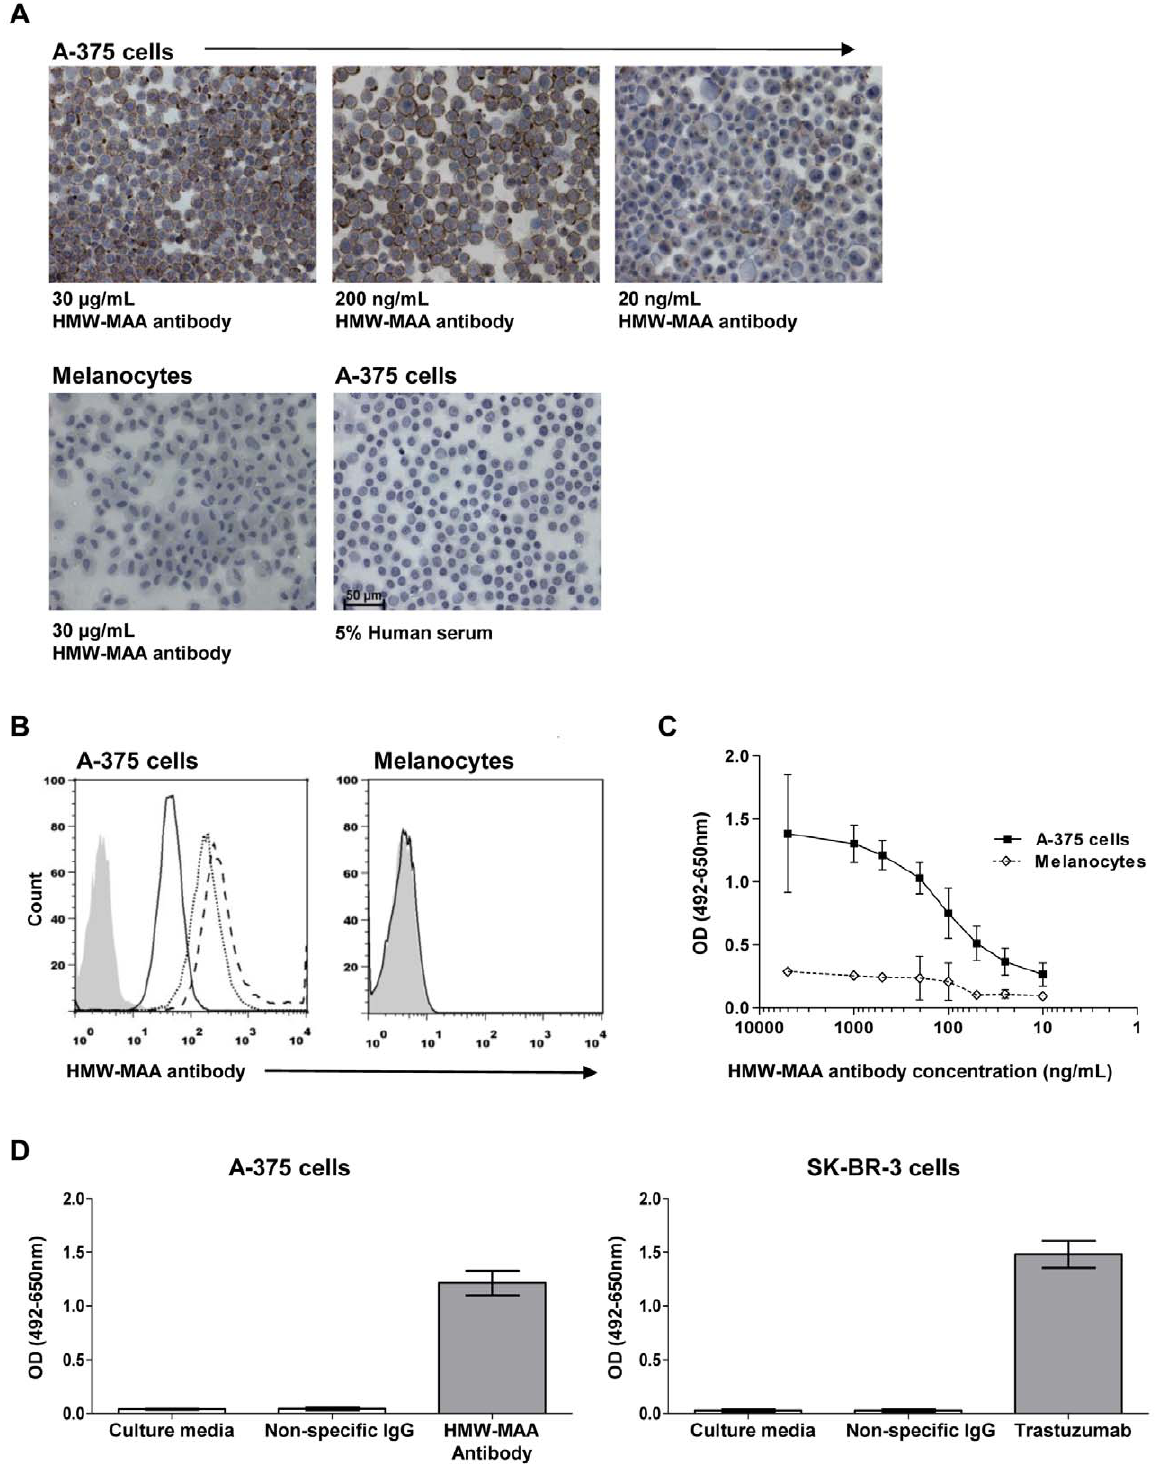
Figure 1. Development of a cell-based ELISA to detect tumor-specific antibodies. ( A ) Immunocytochemistry of cytospin preparations demonstrates that an antibody against the melanoma-associated antigen HMW-MAA, expressed on the surface of A-375 metastatic melanoma cells, can detect the antigen at 30 m g/mL (top left), 200 ng/mL (top middle) and 20 ng/mL (top right), while no binding to melanocytes was seen (bottom left). IgG from 5% human serum (bottom right) did not bind to A-375 cells. ( B ) Flow cytometry analysis demonstrates specific binding of the HMW- MAA antibody to A-375 cells (left) at 30 m g/mL (dashed line), 200 ng/mL (dotted line) and 20 ng/mL (solid line), but not to melanocytes (30 m g/mL HMW-MAA antibody). Isotype control is shown in shaded grey histogram. ( C ) Detection of anti-HMW-MAA antibody binding to melanoma cells over a range of antibody concentrations compared to melanocytes by cell-based ELISA. ( D ) Melanoma-specific antibody HMW-MAA binding to A-375 cells compared to an IgG isotype control or to culture media (left) utilizing the cell-based ELISA. Breast cancer-specific antibody Trastuzumab binding to SK_BR-3 cells compared to an IgG isotype control or to culture media (right). Error bars in figures represent 95% confidence intervals. doi:10.1371/journal.pone.0019330.g001 PLoS ONE |